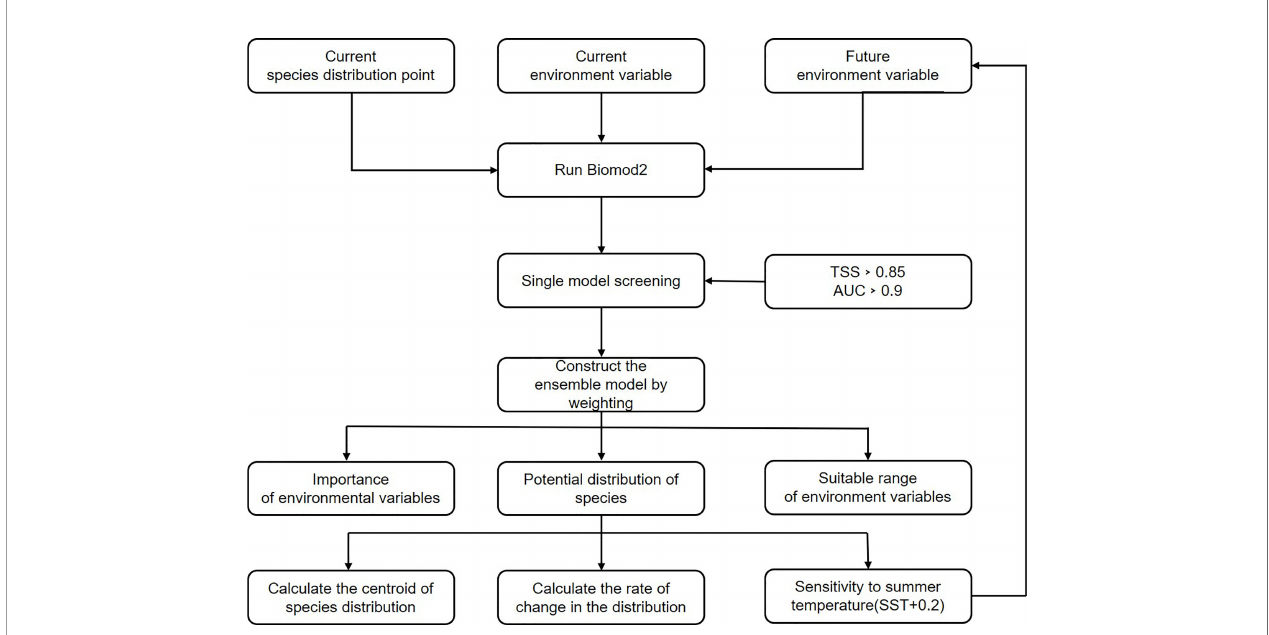
FIGURE 1 | Flowchart for ensemble model construction (when calculating summer tempereture sensitivity, we used each summer temperature increase of 0.2 o C as a new future sea surface temperature variable, all the way up to a 2 o C